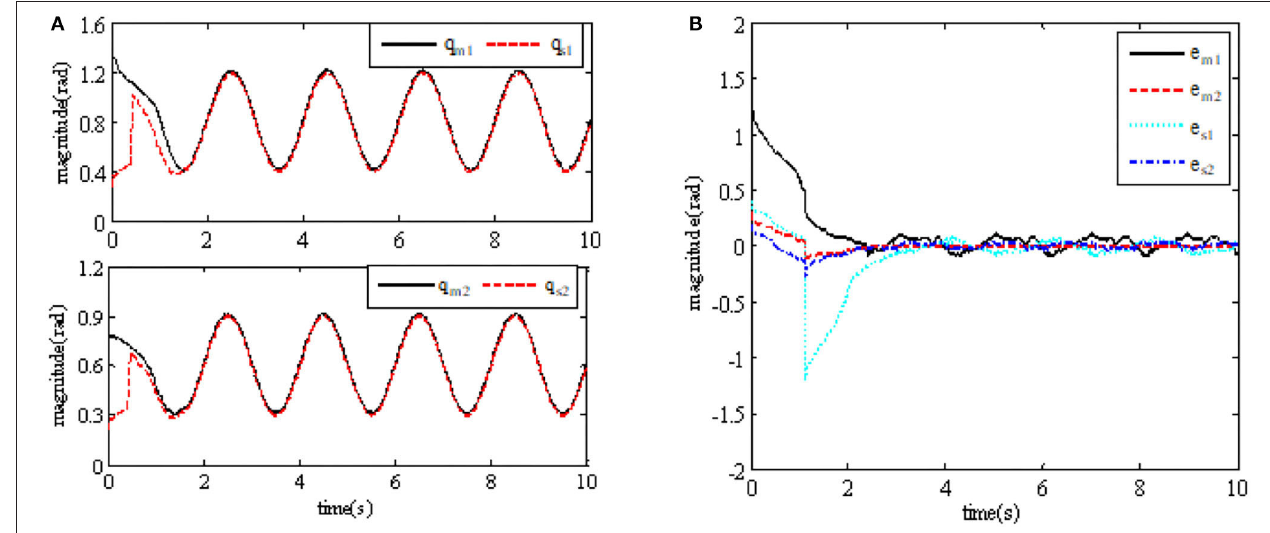
FIGURE 2 | Tracking performance between master and slave robots. (A) Tracking of master and slave robots’ joints; (B) position tracking error of master and slave robots’ joints.